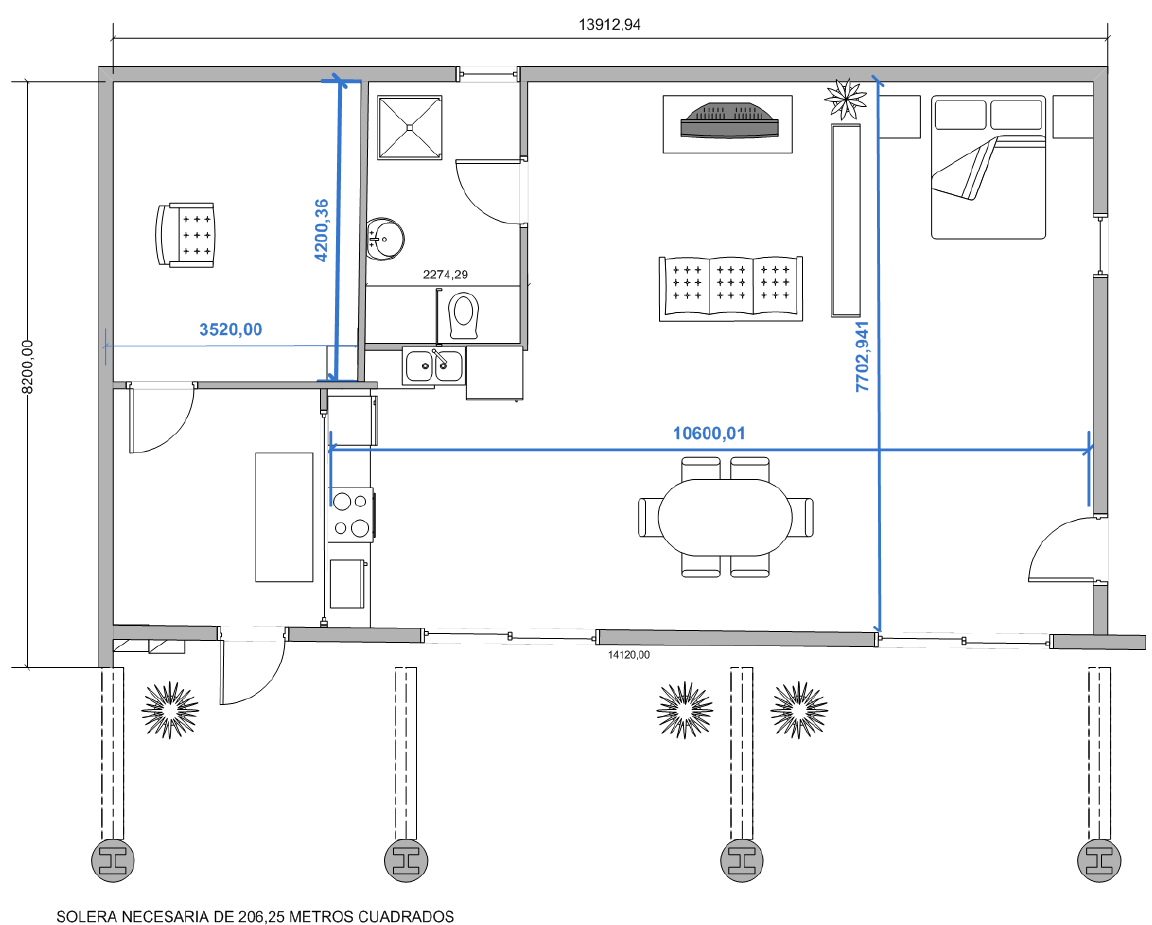
Figure 5. Map of the Smart House Living